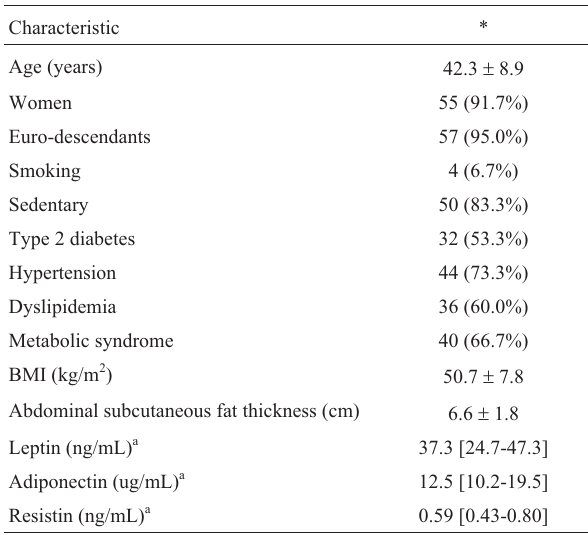
Table 1 - Baseline clinical characteristics of the 60 morbidly obese en- rolled subjects.